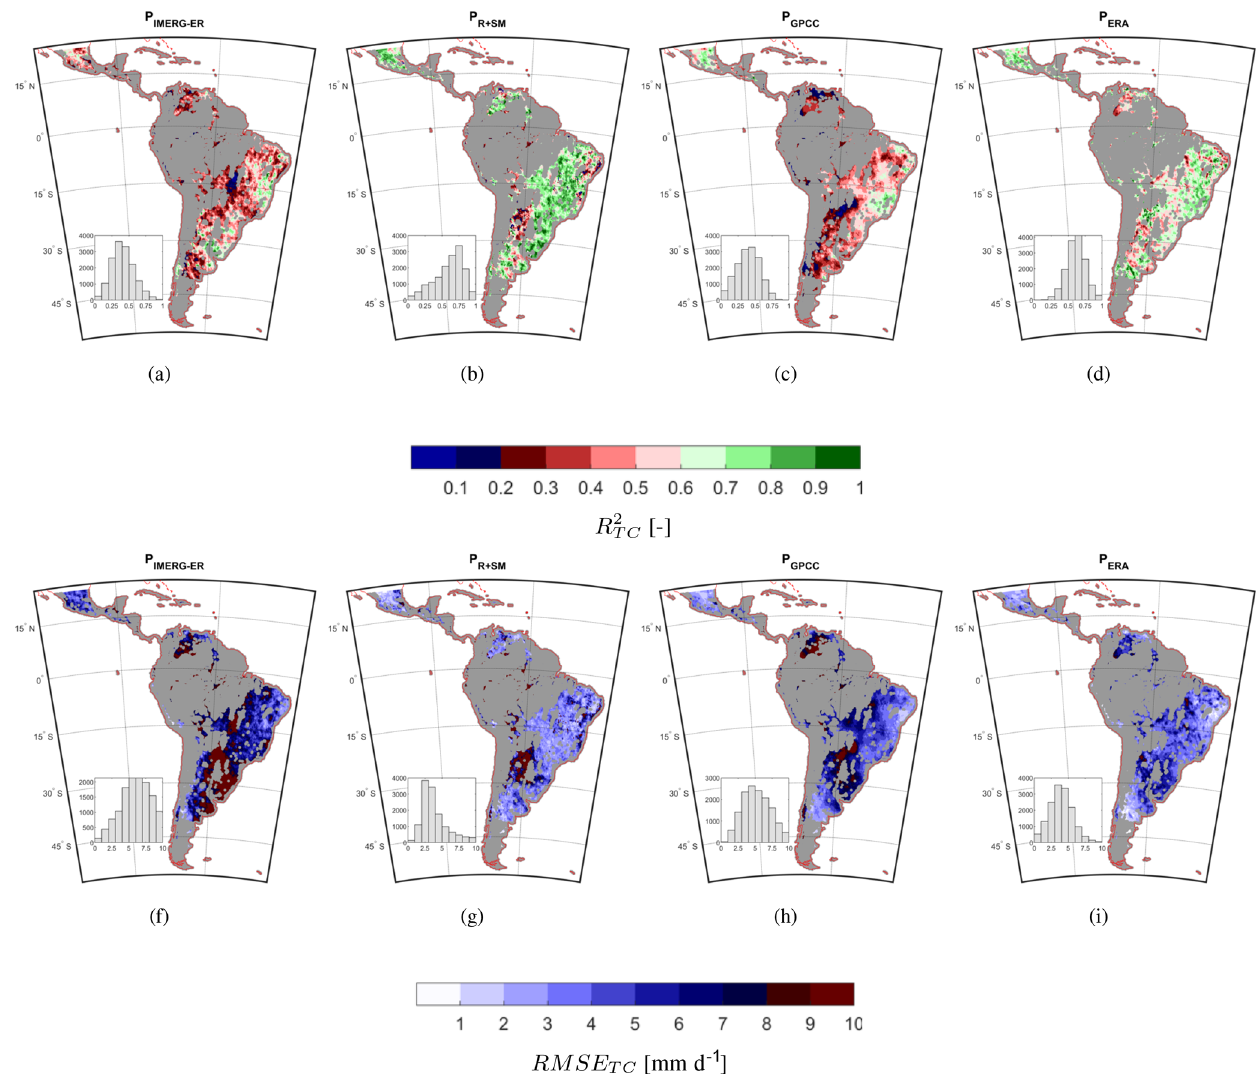
Figure 10. As in Fig. 9 but for South